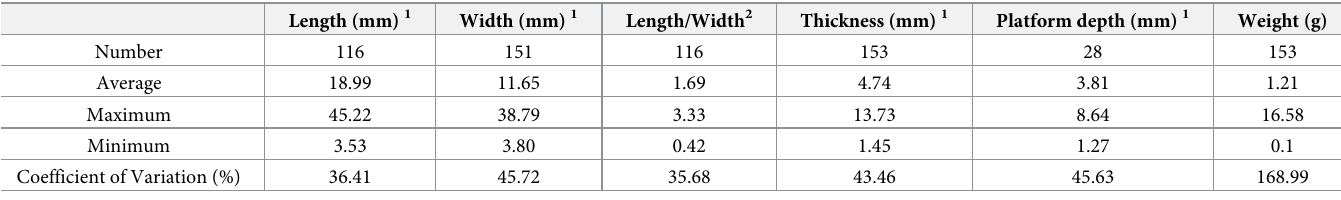
Table 8. Dimensions of chert and chalcedony microlith manufacturing rejects, Horizon IV, Saruq